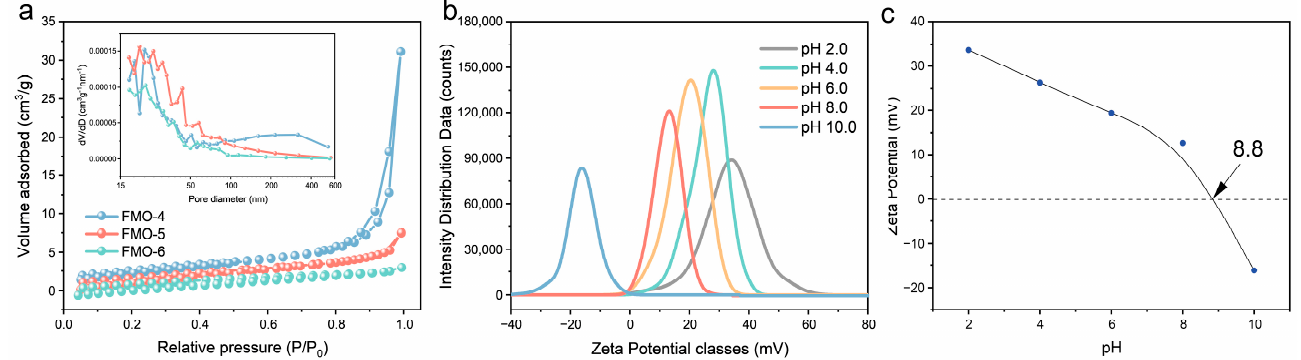
Figure 2. ( a ) Nitrogen adsorption–desorption isotherms (inset: pore size distribution curve for FMO); ( b ) Zeta-potential in solutions of various pH with 2, 4, 6, 8, and 10; ( c ) Zeta potentials of FMO-6 at different pH values.